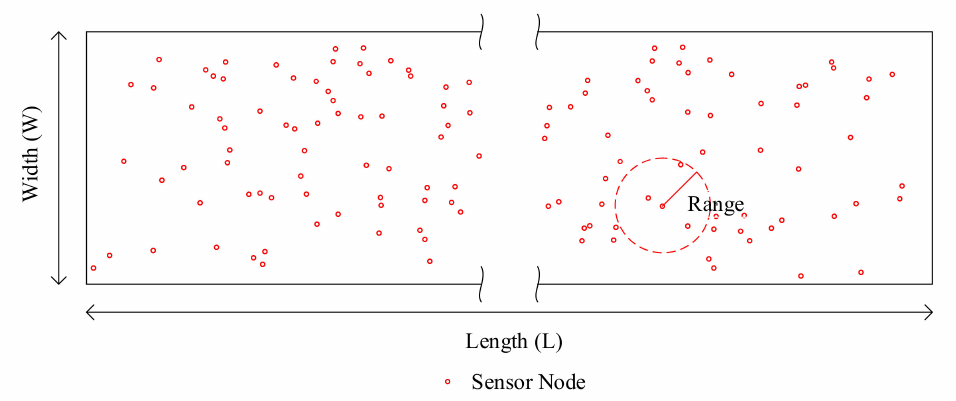
Figure 1. Illustration of a thick linear sensor network. Sample parameter values: L = 10,000 m, W = 500 m, and range = 100